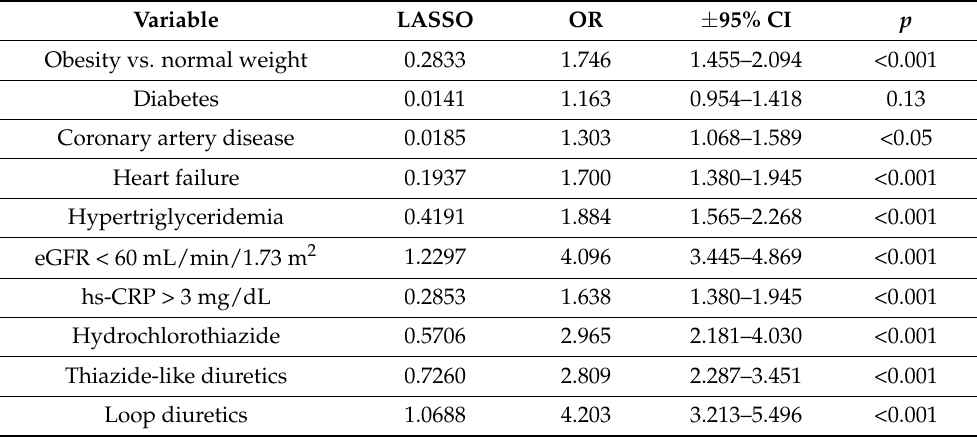
Table 3. Risk factors of hyperuricemia. The results of LASSO and multivariable logistic